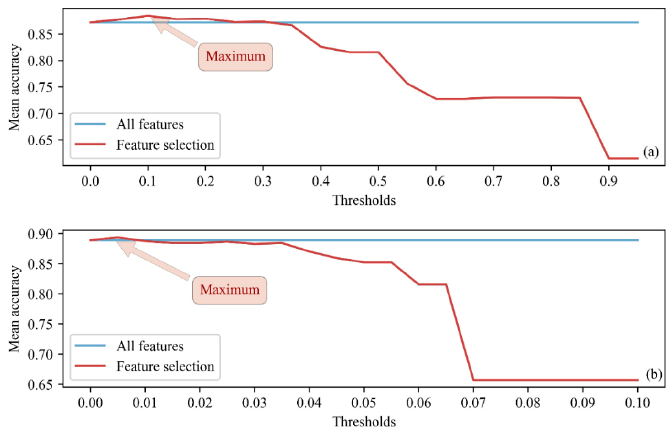
Figure 5. The learning curves of the LR ( a ) and RF ( b ) models.